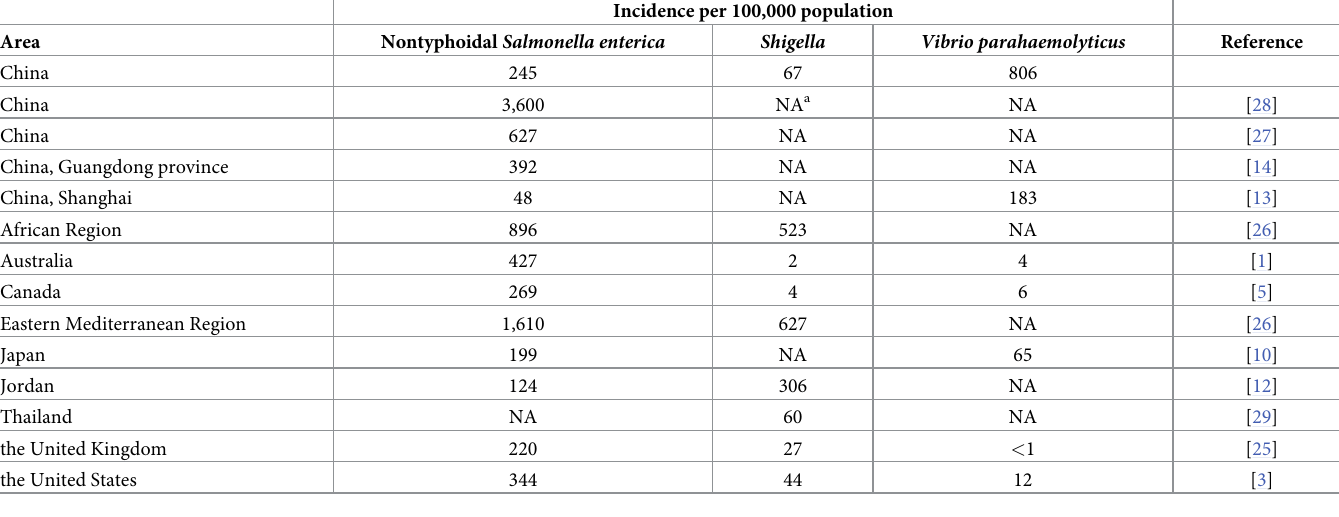
Table 4. Incidence of nontyphoidal Salmonella enterica , Shigella and Vibrio parahaemolyticus foodborne gastroenteritis, by